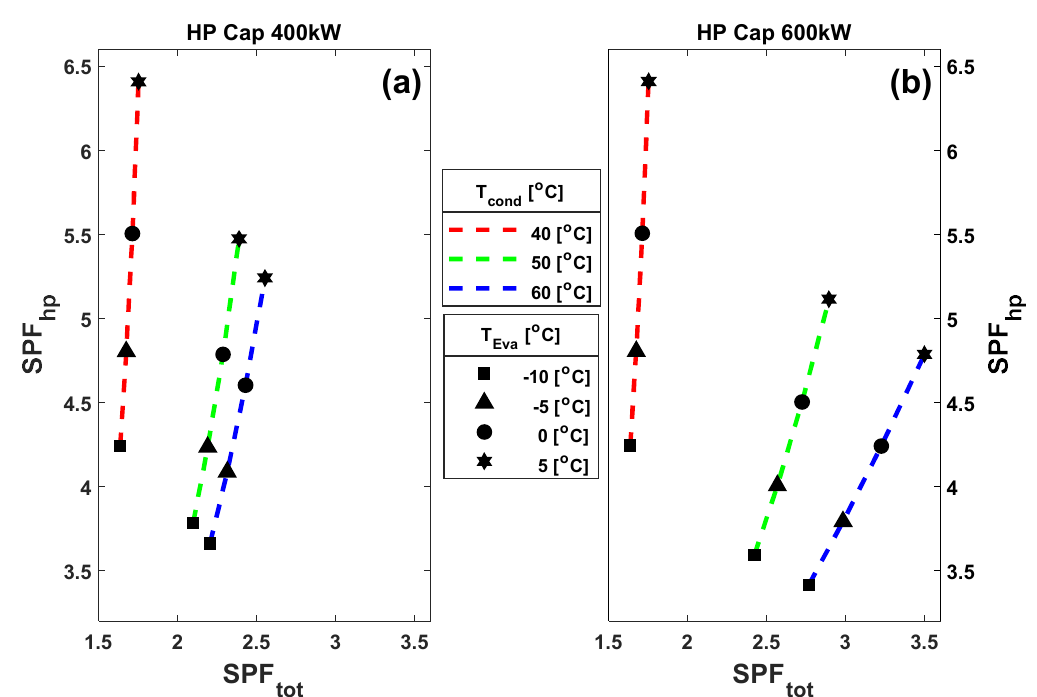
Figure 6. The influence of the evaporator temperature, condenser temperature, and the heat pump capacity: ( a ) 400 kW; ( b ) 600 kW on the heat pump and total SPF values for the ventilation temperature ratio of 70/30 °C/°C, and the heat recovery of 50%.